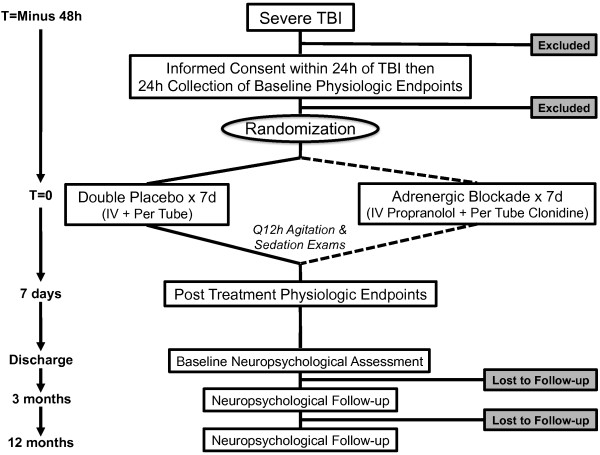
CONSORT diagram of theDASH After TBI Study.